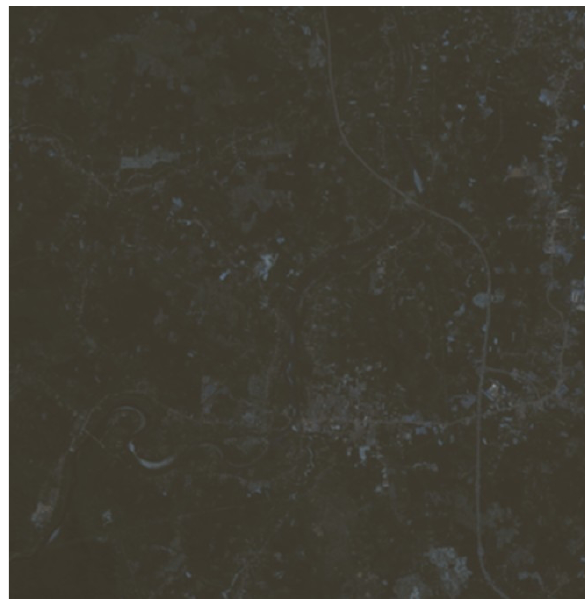
Figure 2.b: A 2x up-scaled version of the 330x330 pixels to match with 660x660 original